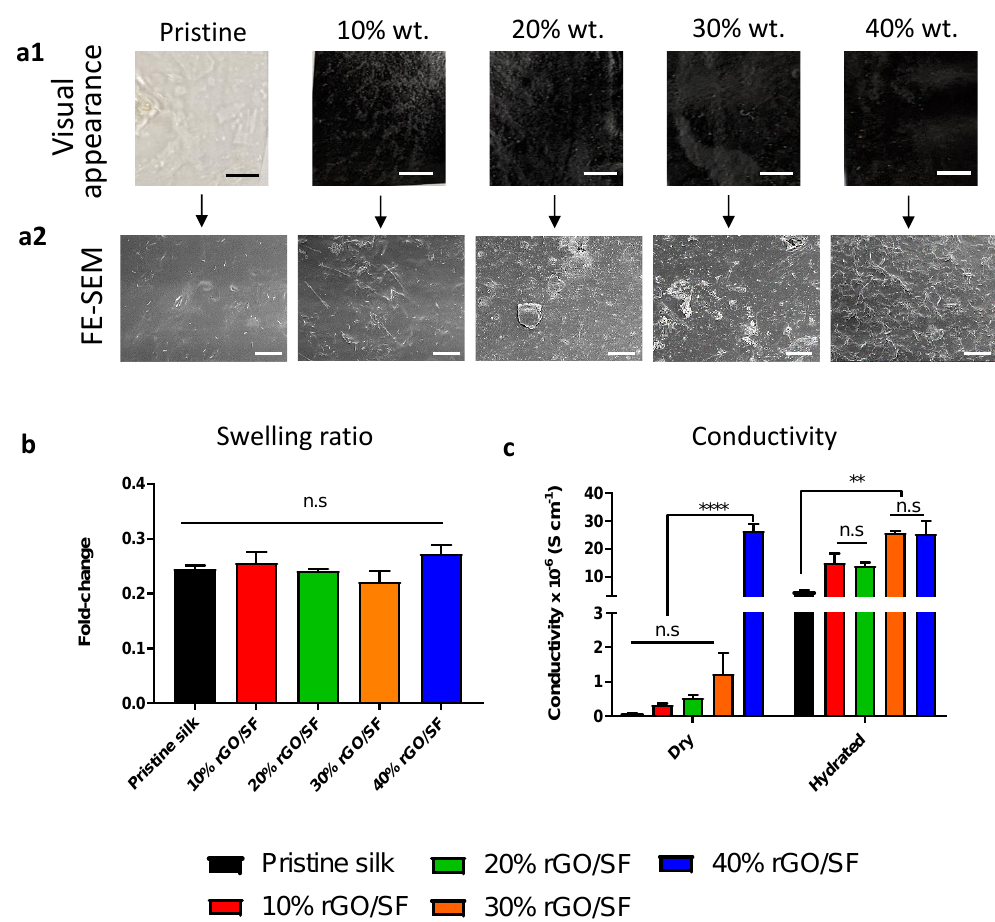
Figure 1. Electroconductive/active silk-based scaffolds. ( a ) Representative ( a1 ) macroscopic visual appearance of silk-based films and ( a2 ) FESEM micrographs at increasing rGO loading; scale bars at 5 mm and 10 μm respectively. ( b ) Swelling ratio ( n = 3 per sample type). ( c ) Conductive properties ( n = 4 per sample type) in the dry and hydrated states. The differences between the experimental groups were analyzed by one-way or two-way ANOVA using Tukey’s post hoc test for multiple comparison. n.s, nonsignificant; ** p < 0.01, **** p < 0.0001.